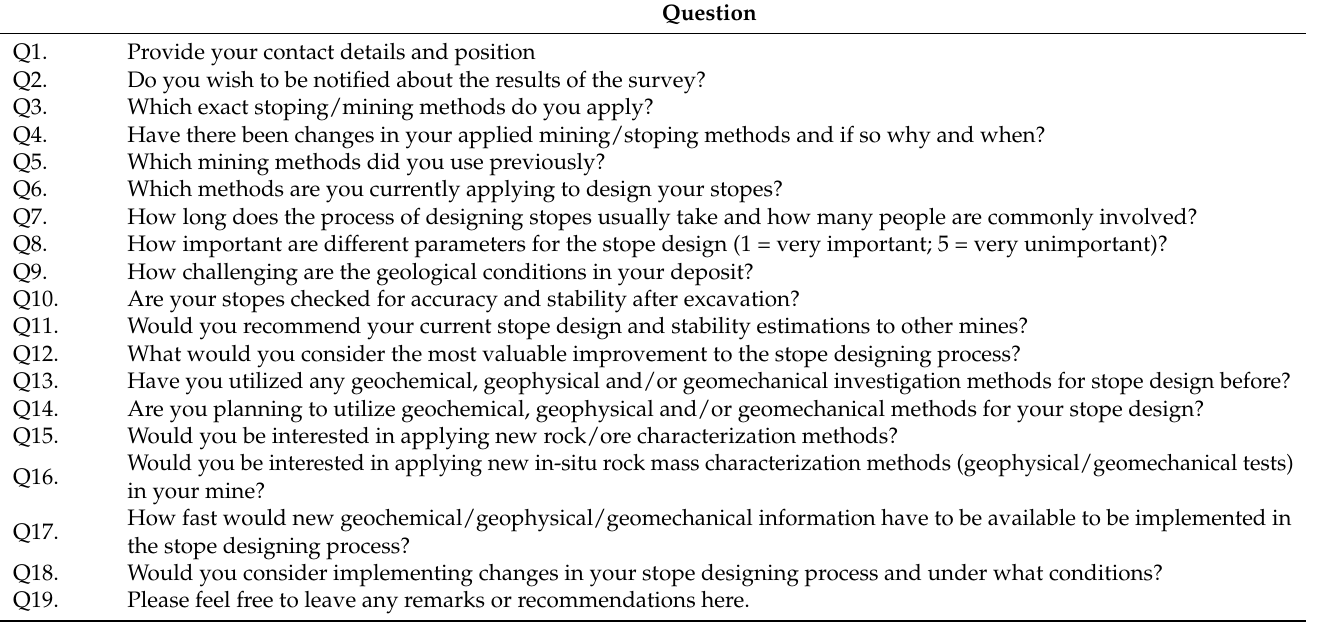
Table 1. Questions asked in the industry survey on stope design